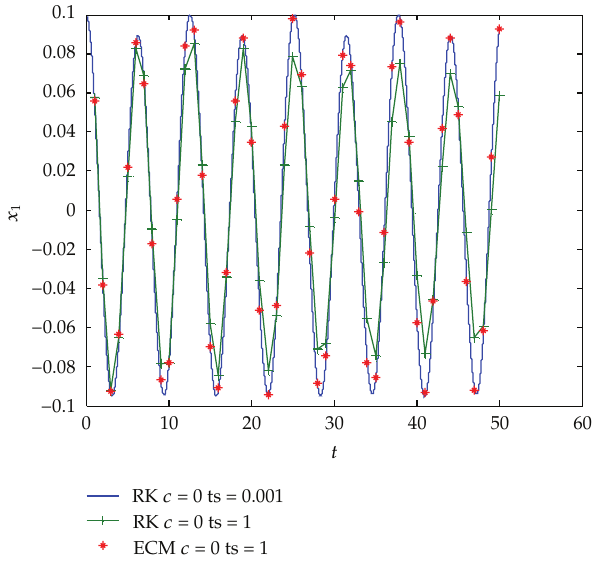
Figure 10: Displacement trajectory.